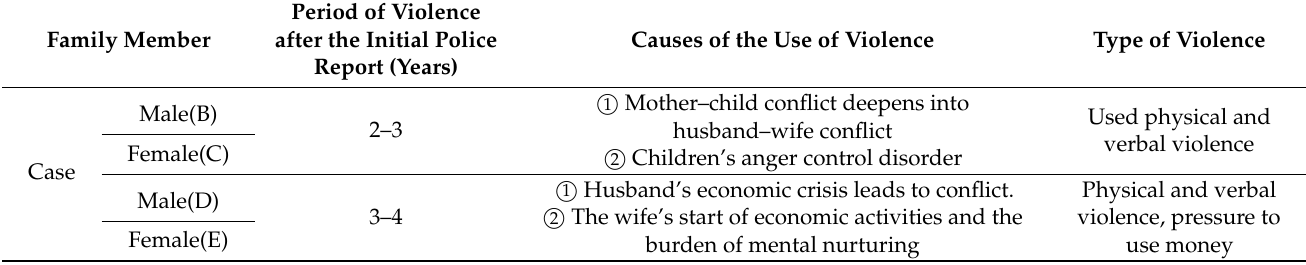
Table 2. Violence characteristics of the study